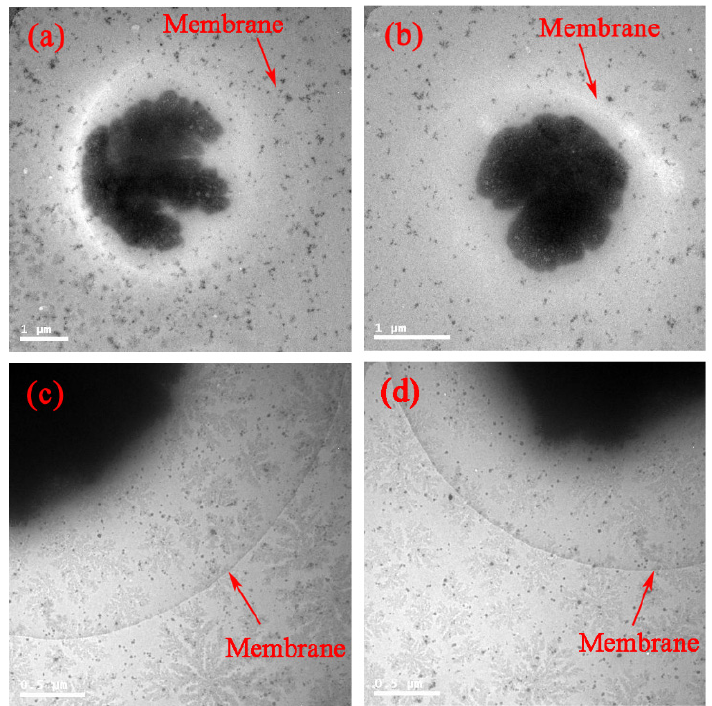
Figure 4. In vitro bio-distribution and TEM images of 14.4 and 30.5 nm PEG-coated GNPs in H22 ( a , c ) and HepG2 ( b , d ) cell .